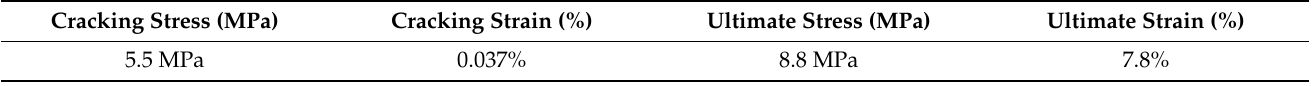
Table 3. Mechanical properties of LECC.